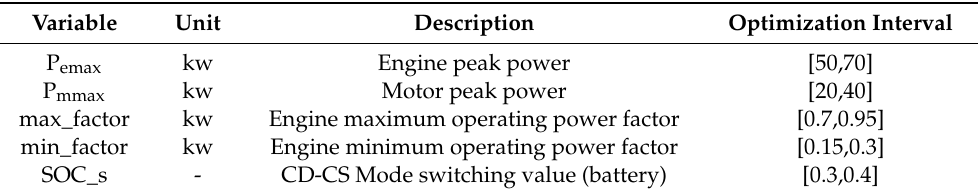
Table 3. Optimization variable